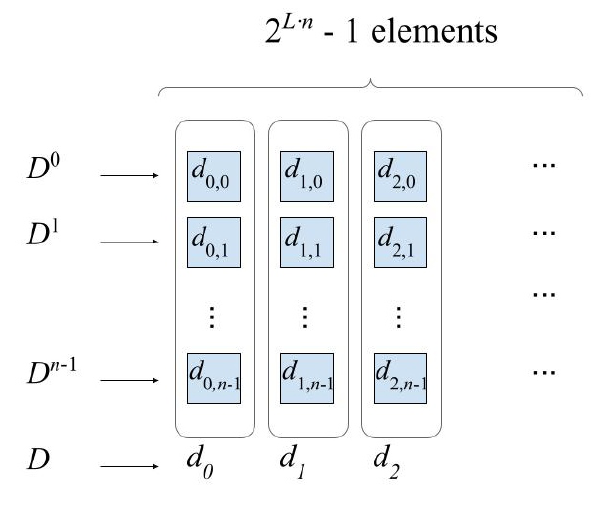
Figure 2. Relationship between m -sequences in the extended and base fields.